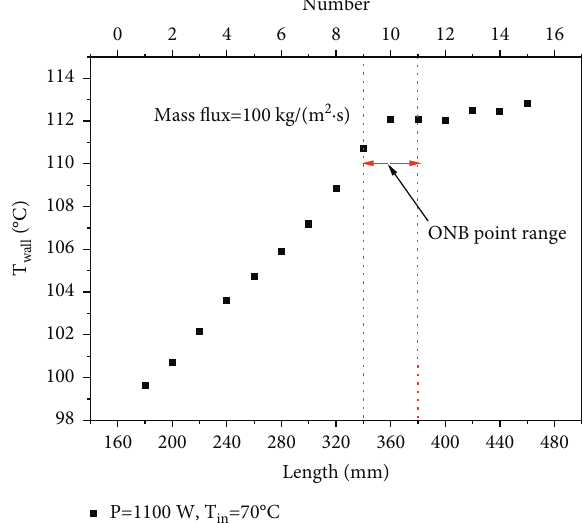
Figure 6: Axial wall temperature distribution in channel b ( T